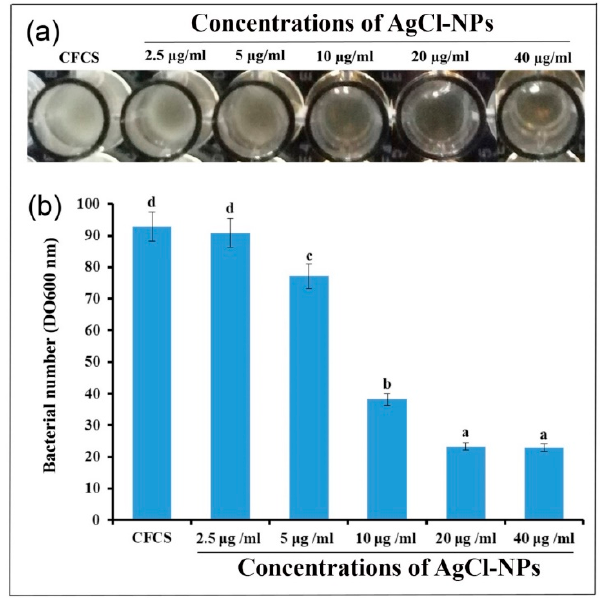
Figure 9. Determination of minimum inhibition concentration of biosynthesized AgCl-NPs by CFCS of bacterium strain IMA13 against bacterium phytopathogenic strain YY06: ( a ) the visible bacterial concentration decreased from left to right on one row of the 96-well microtiter plate; ( b ) inhibitory activity of different concentrations of AgCl-NPs. Vertical bars represent standard errors of the means ( n = 3). The different letters are significantly different ( p < 0.05) by LSD test; values are average of three replicates.